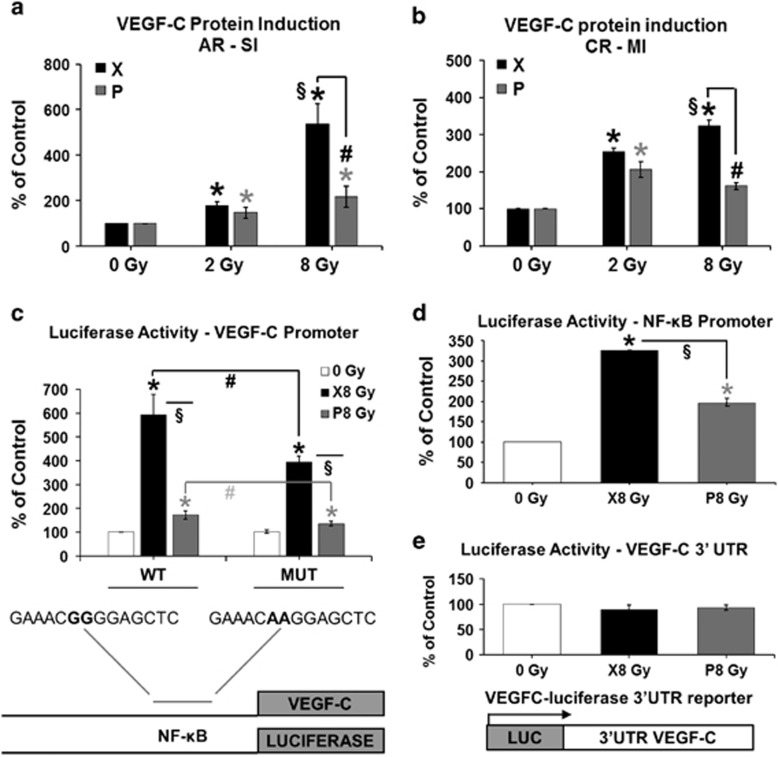
VEGF-C protein expression levels and regulation in CAL33 cells following P or X irradiation. (a) VEGF-C protein levels at 48 h post-single irradiation (AR-SI): * and *, significantly (P<0.05) increased levels after a low (2 Gy) or high (8 Gy) dose of P and X irradiation, respectively, as compared to CT; #, significantly decreased levels after a high dose of P, as compared to X irradiation; §, significantly increased levels after a high, as compared to a low X irradiation dose; (b) VEGF-C protein levels after cell expansion following the third irradiation (CR-MI): * and *, significantly increased levels after low and high doses of P and X irradiation, respectively, as compared to CT; Concentration in ng/ml, normalized to 1 × 106 cells, and represented as percentage of CT. #, significantly decreased levels after high doses of P, as compared to X irradiation; §, significantly increased levels after high, as compared to low doses of X irradiation; (c) Activity of a short vegf-c promoter (CR-MI); (d) Activity of an artificial promoter having three binding sites for NF-kB (CR-MI); (e) Activity of a VEGF-C 3′UTR reporter gene (CR-MI). * and *, significantly (P<0.05) increased promoter activity after P and X irradiation, respectively, as compared to CT; # and #, significantly decreased activity of MUT, as compared to WT vegf-c promoter after P and X irradiation, respectively; §, significantly decreased promoter activity after P, as compared to X irradiation. CT, control (non-irradiated cells); MUT, mutated, WT, wild type.